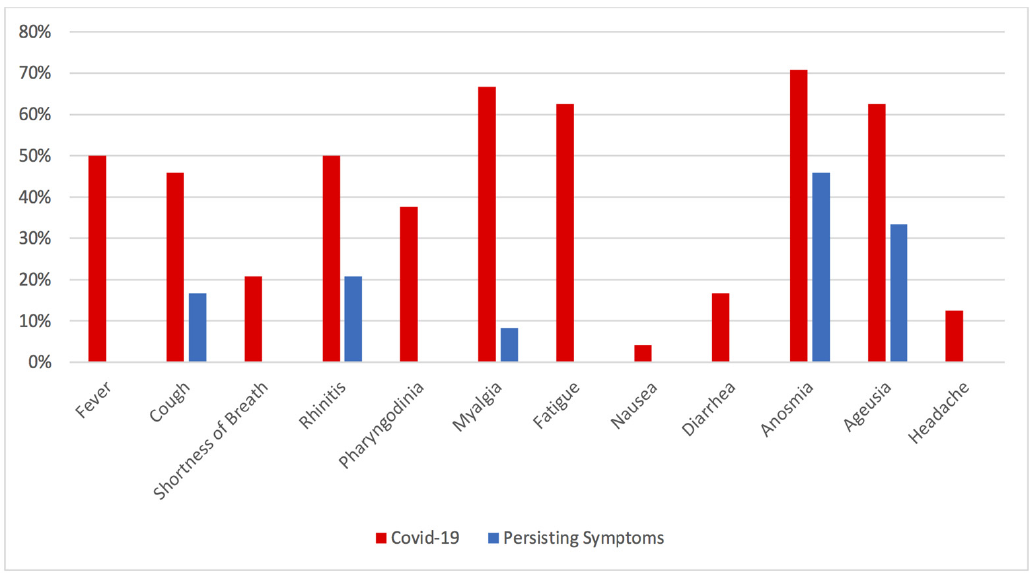
Figure 1. Clinical Presentation of COVID-19 in athletes and Persisting Symptoms .